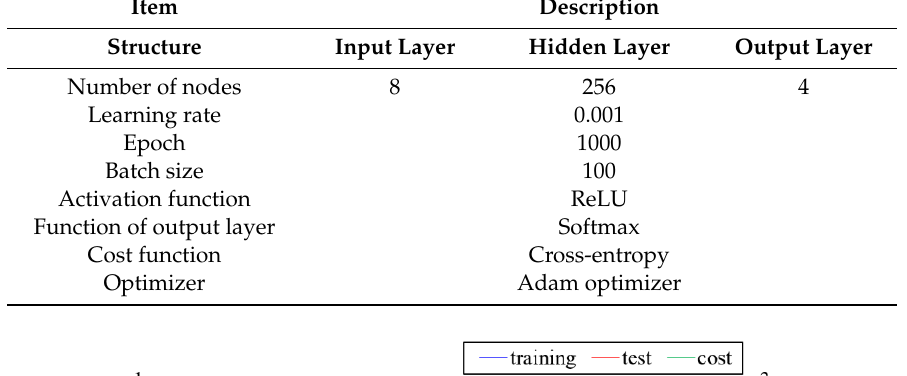
Figure 10. Structure of the deep neural network (DNN) model to classify the weld quality. Table 5. Summary of DNN model implementation.